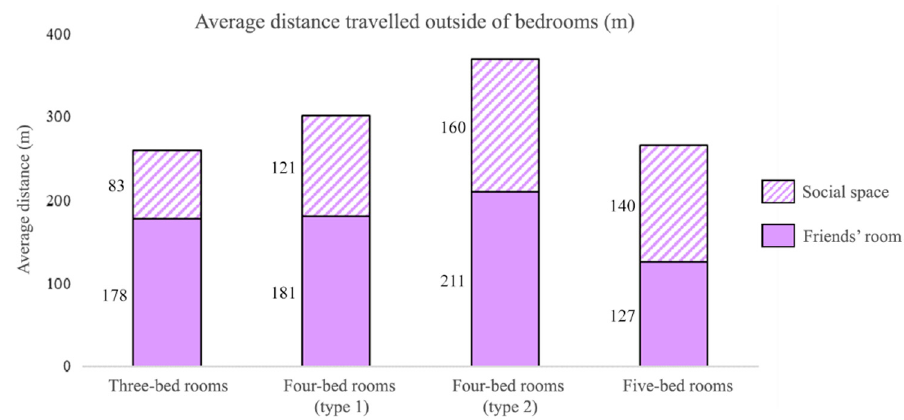
Figure 9. Average distance residents travelled outside of bedrooms. Residents in four-bed rooms (type 2) travelled the farthest to both social space and friends’ rooms.